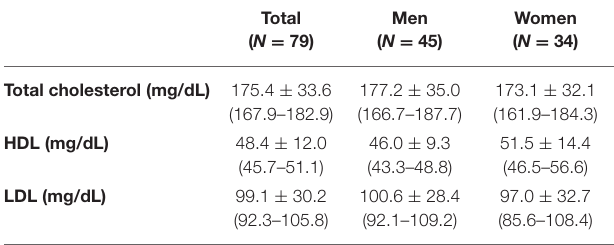
CP, cerebral palsy; GMFCS, Gross Motor Function Classification System; SPPB, Short PhysicalPerformanceBattery;HDL,high-densitylipoprotein;LDL,low-densitylipoprotein. * Missing data for each column are shown by the total number of participants. Data are shown as mean ± SD (95% confidence intervals).